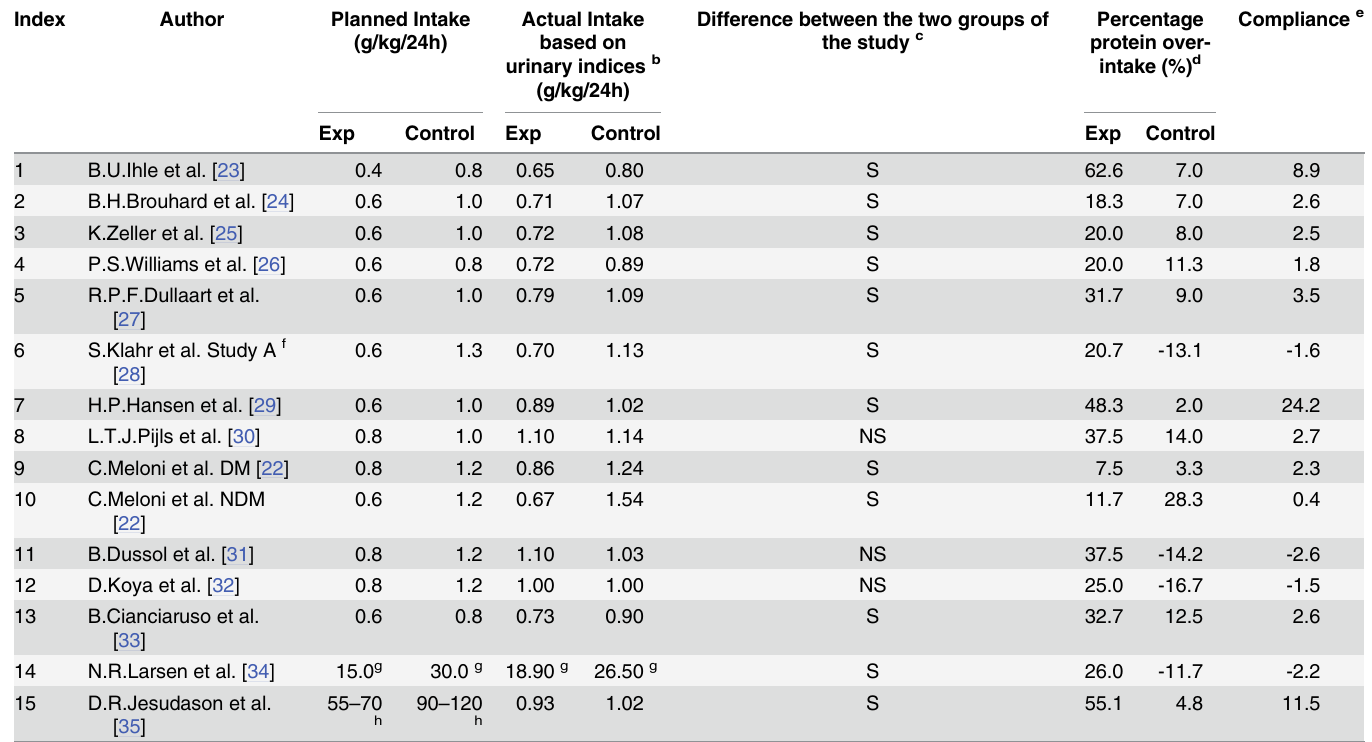
Table 2. Dietary protein intervention in both arms for each study and the assessment of compliance for each study a